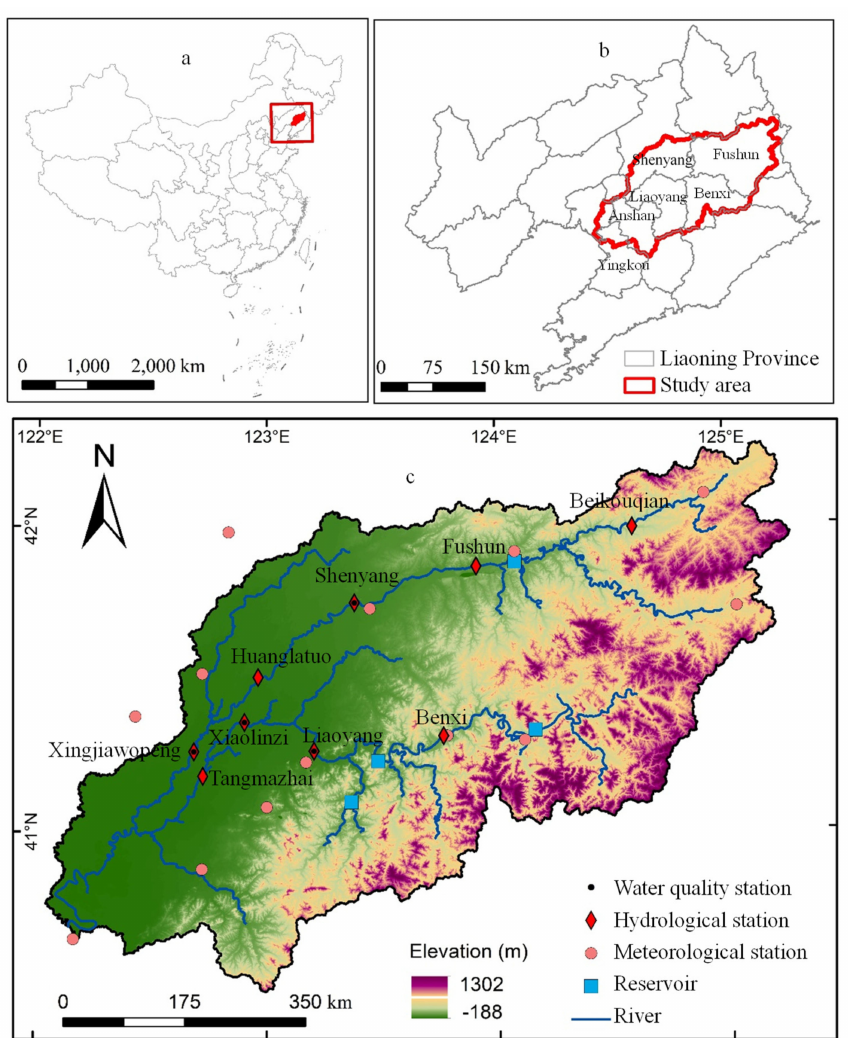
Figure 1. Location of the study area. ( a ) China; ( b ) The study area in Liaoning Province; ( c ) The study